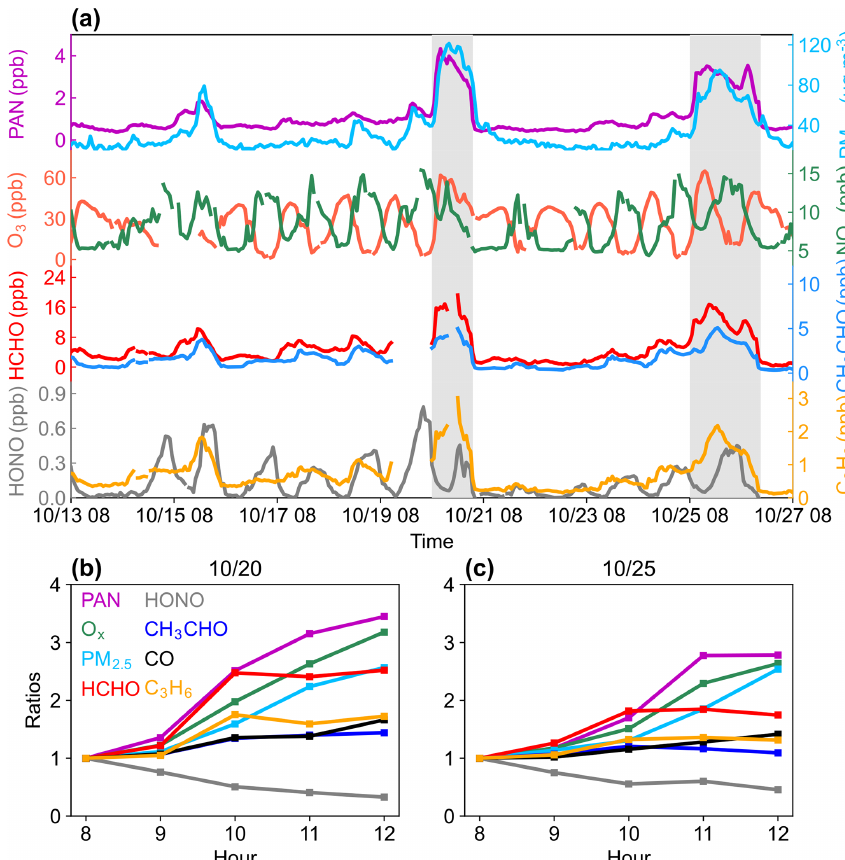
Figure 2. (a) Observed hourly concentrations of PAN (ppb), PM 2 . 5 (micrograms per cubic meter; hereafter µgm − 3 ), O 3 (ppb), NO x (ppb), HCHO (ppb), CH 3 CHO (ppb), HONO (ppb), and C 3 H 6 (ppb) at the SDZ site from 13 to 27 October 2020. The shades denote the days when hourly PAN concentrations exceeded 3ppb. (b, c) Ratios of atmospheric constituent concentrations to the concentrations at 08:00LT (local time), in the morning on 20 and 25 October, when substantial PAN growths took